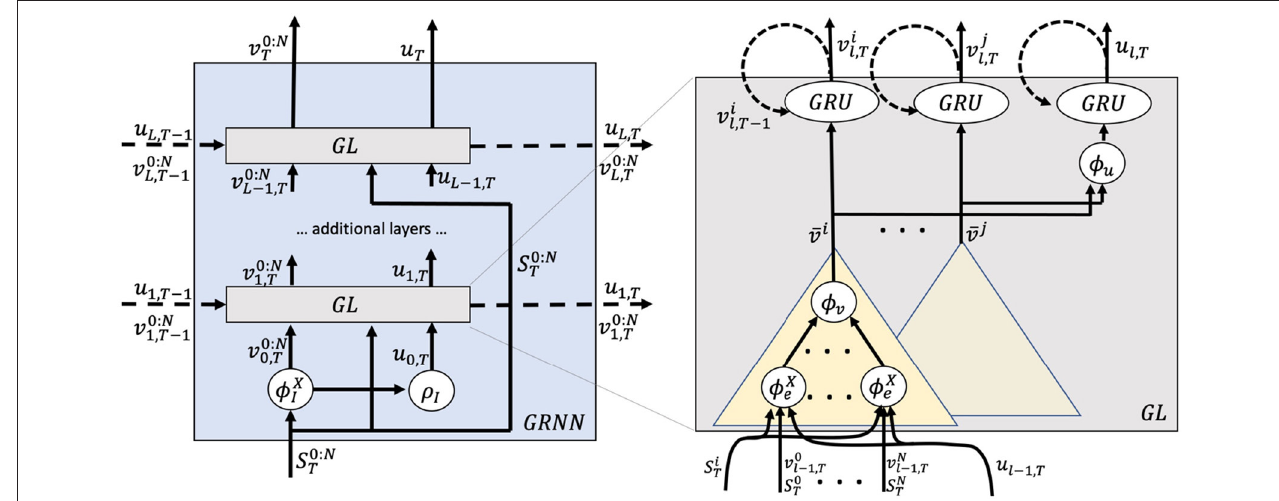
FIGURE 1 | Graphical representation of the graph recurrent neural net